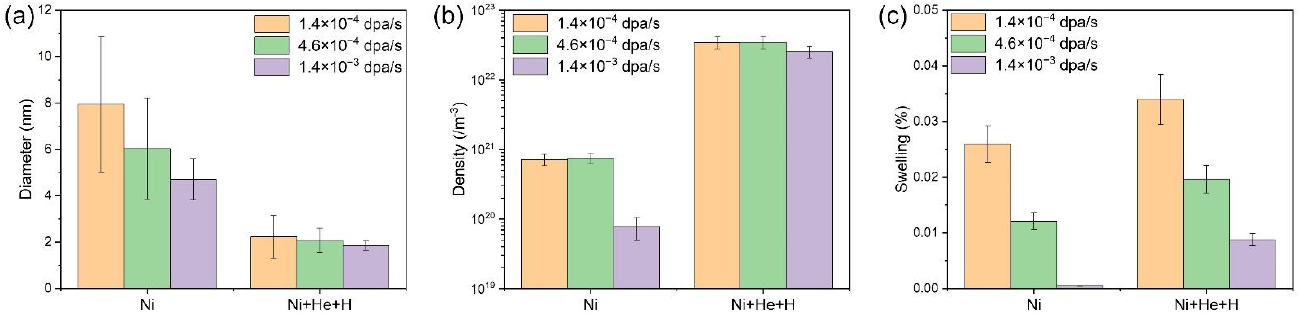
Figure 3. The statistical results of ( a ) cavity average size, ( b ) number density, and ( c ) volume swelling. The x -axis shows the irradiation types of single Ni and triple (Ni+H+He) ions. In ( a – c ), the orange, green, and purple correspond to the dose rates of 1.4 × 10 − 4 dpa/s, 4.6 × 10 − 4 dpa/s, and 1.4 × 10 − 3 dpa/s, respectively.